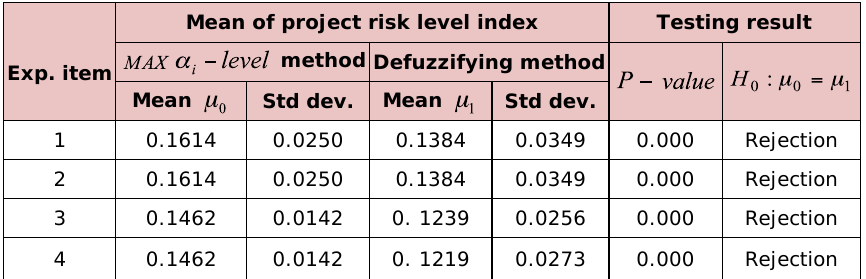
Table 2. “Mean of PSRI“.